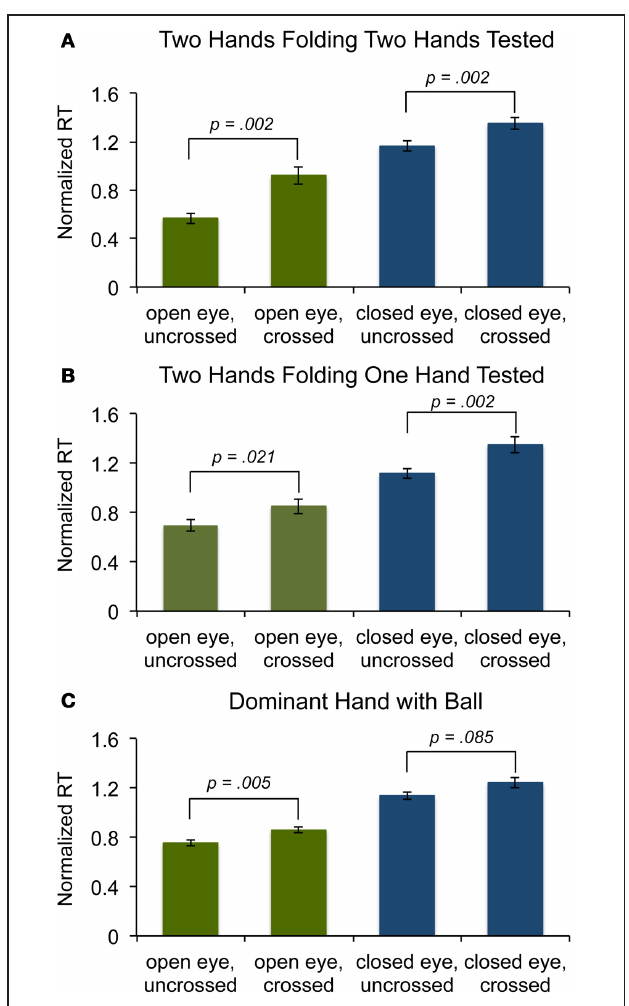
FIGURE 2 | Results from Experiments. (A) Experiment 1: Normalized reaction time (RT) for Hand-Reversal Illusion with open (green) and closed eyes (blue). Error bars represent the standard error across participants. (B) Experiment 2: Same as (A) but tested fingers from only one hand. (C) Experiment 3: Same as (A) but with only one hand grabbing the